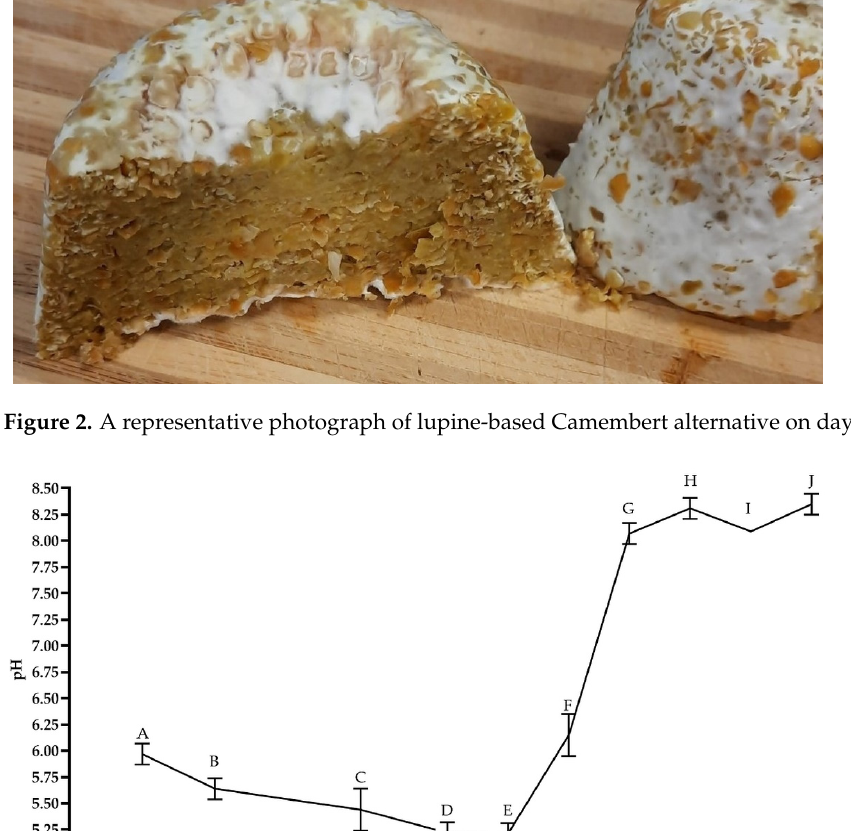
Figure 2. A representative photograph of lupine-based Camembert alternative on day 28.